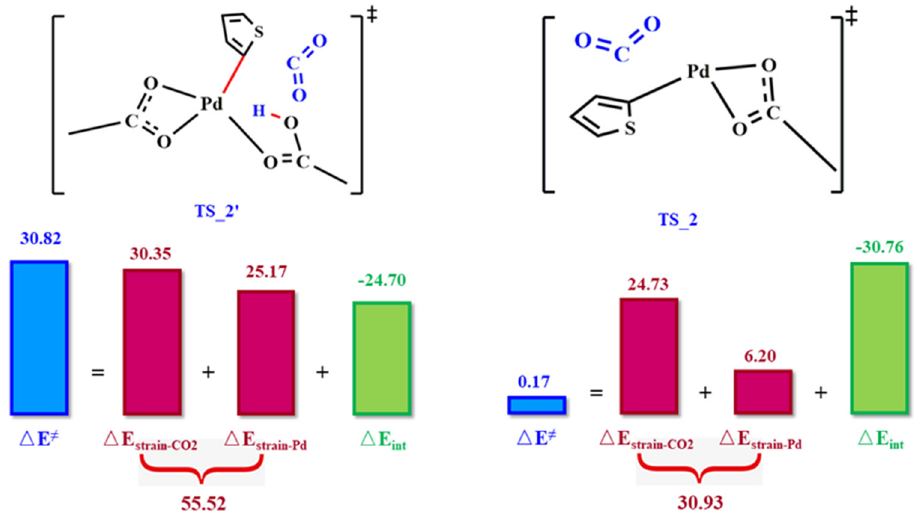
Figure 5. Distortion/interaction model analysis for the transition state structures TS_2 and TS_2 ′ of the CO 2 insertion step (the unit of the energy term is kcal/mol).